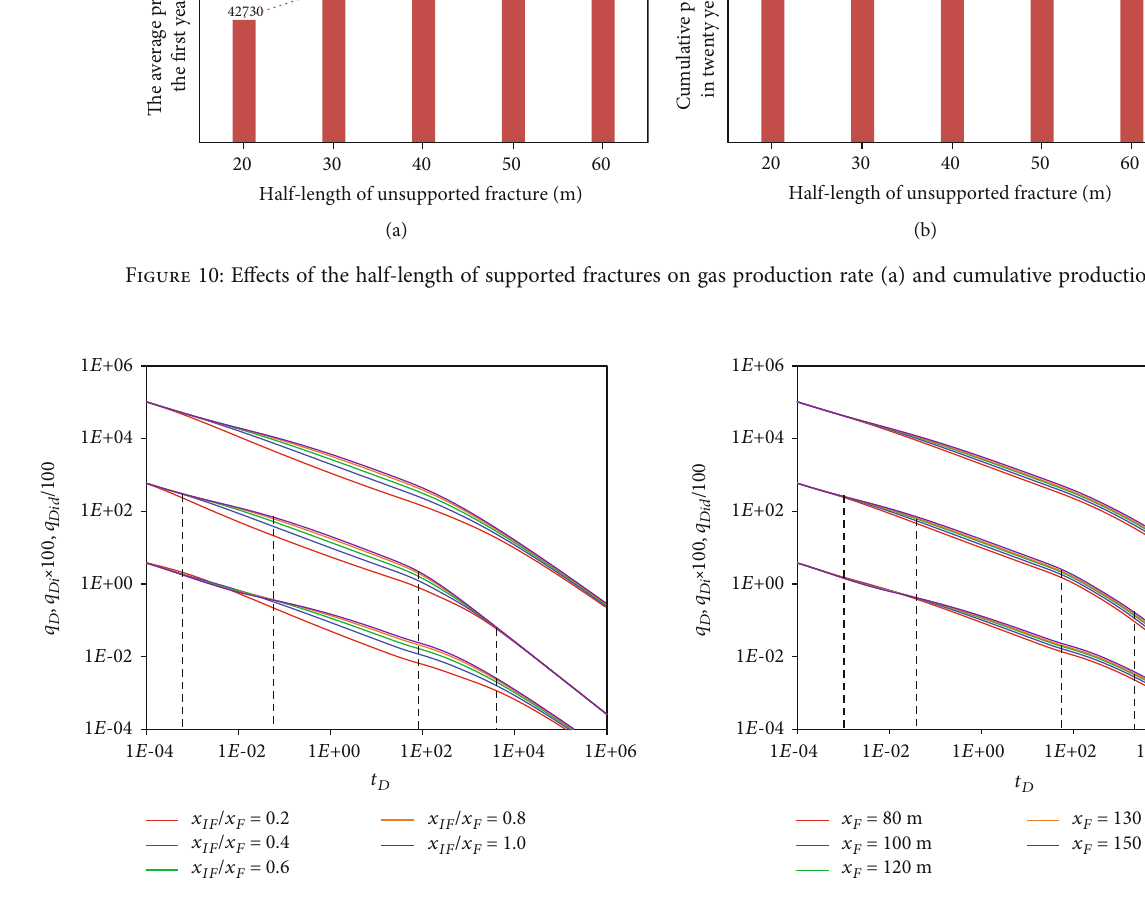
Figure 11: E ff ects of the x IF / x F on normalized gas production. Figure 12: E ff ects of the x F on normalized gas